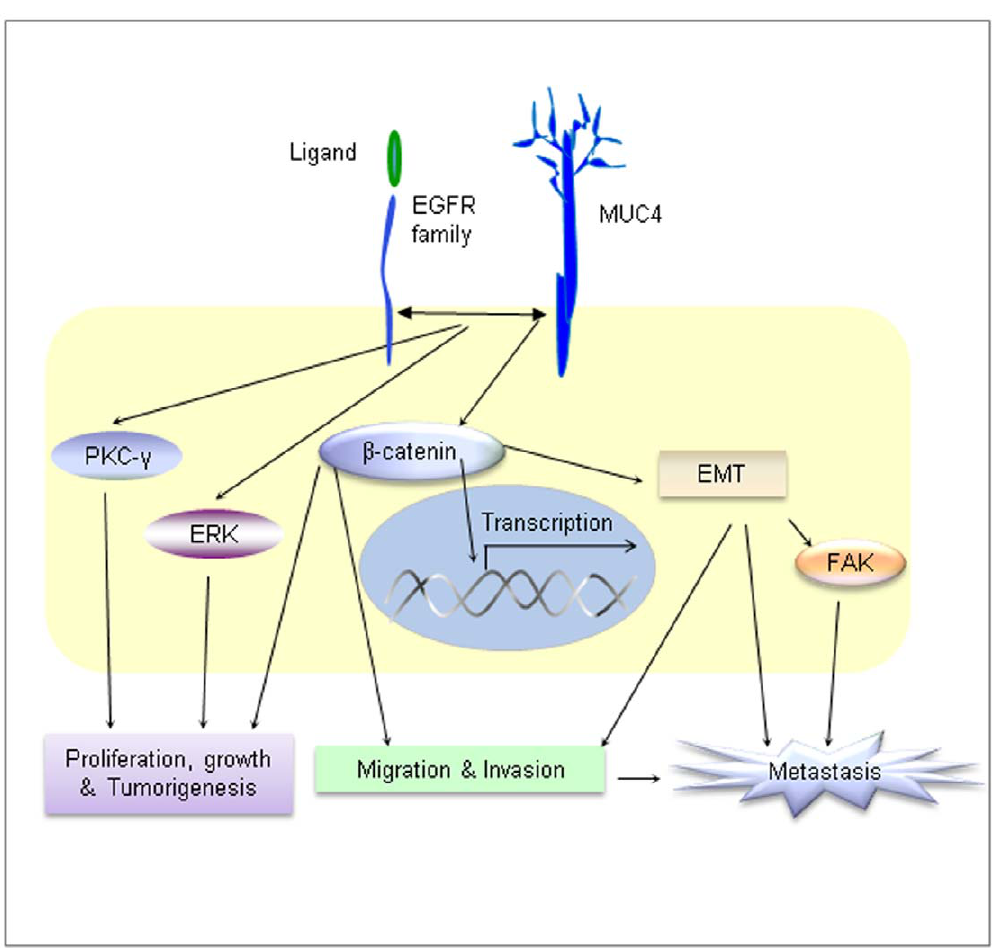
Figure 8. A schematic diagram showing the contribution of MUC4 in the overall aggressiveness of TNBC cells. MUC4 maintains the sustained expression of EGFR family proteins and thereby potentiates downstream signaling events mediated through the PKC- c and Erk1/2 signaling. MUC4 maintains sustained expression of b -catenin, which induces proliferation, tumorigenesis, migration, invasion, and metastasis. Figure S2 MUC4 down-regulation maintained in a tu- mor generated by the orthotopic implantation of MDA- MB-231-shMUC4 cells in mammary fat pads of nude mice. (A) Real-time PCR analysis of tumor samples. A total of real-time-PCR using MUC4 specific primers and SYBR green master mix. The GAPDH specific primers were used as control.